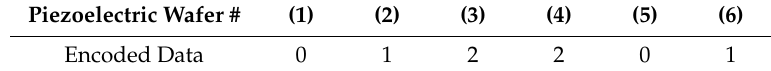
Table 2. The encoded data retrieved from the conductance spectra using the threshold-based criteria.